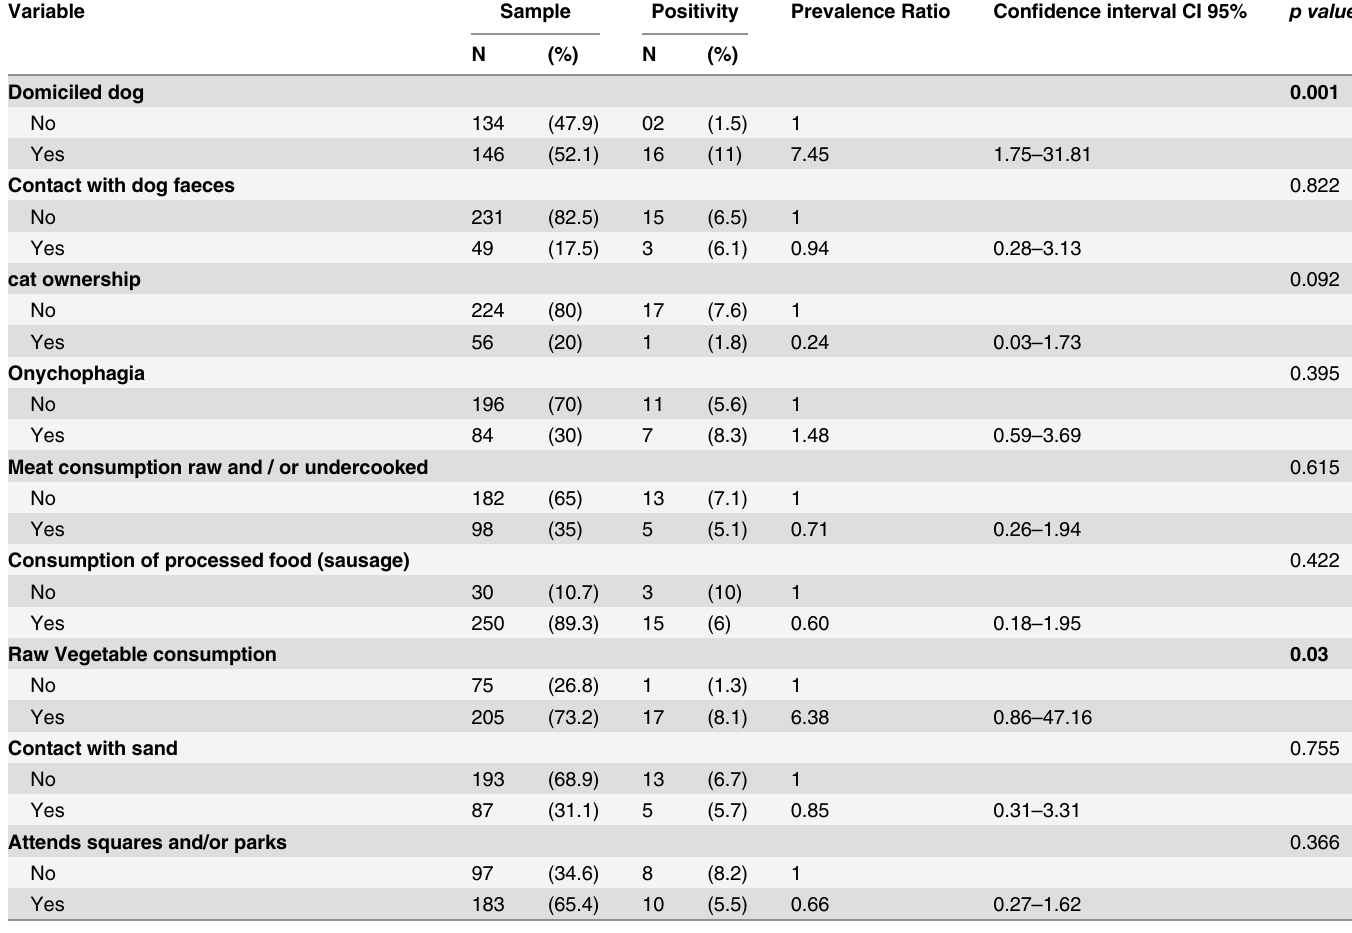
Table 2. The seropositivity (IgG) for Toxocara spp. according to the epidemiological factors in the pregnant women attended at the University Hos- pital of Rio Grande — RS, from May 2011 to April 2012(n =